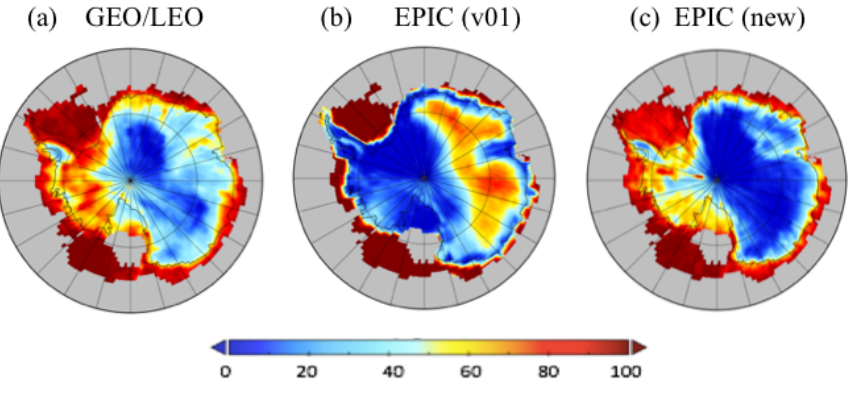
Figure 8. Cloud fractions derived from (a) composite GEO/LEO retrievals, (b) original EPIC cloud mask, and (c) new EPIC cloud mask over Antarctica in January 2017.